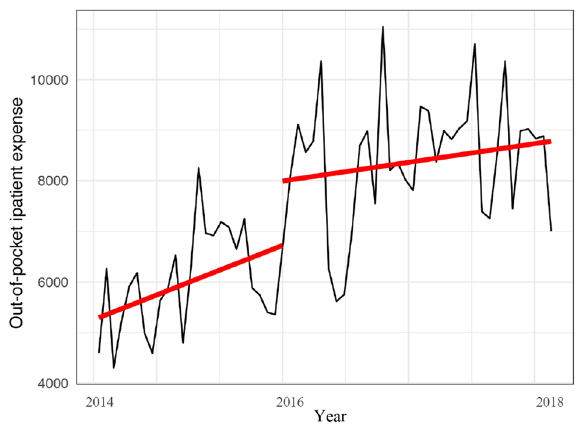
Figure 3. Trend of per capita out-of-pocket inpatient expense (¥) from 2014 to 2018.